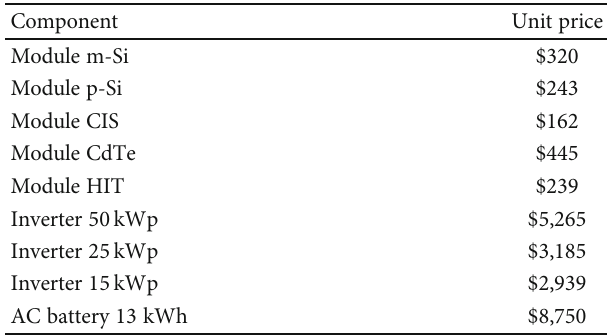
Table 2: Cosf of the designed BAPV system main